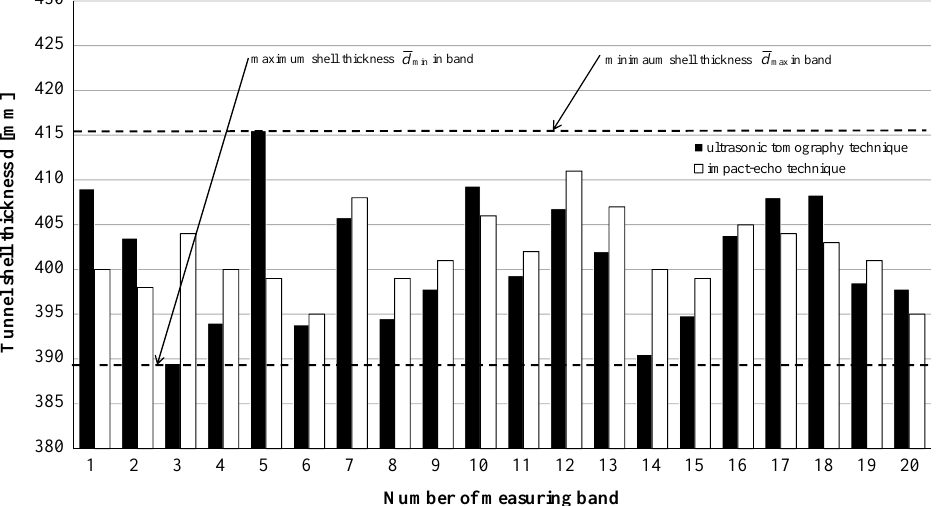
Fig. 14. Thickness of the concrete tunnel shell in particular measuring places, determined using ultrasonic tomography and impact-echo